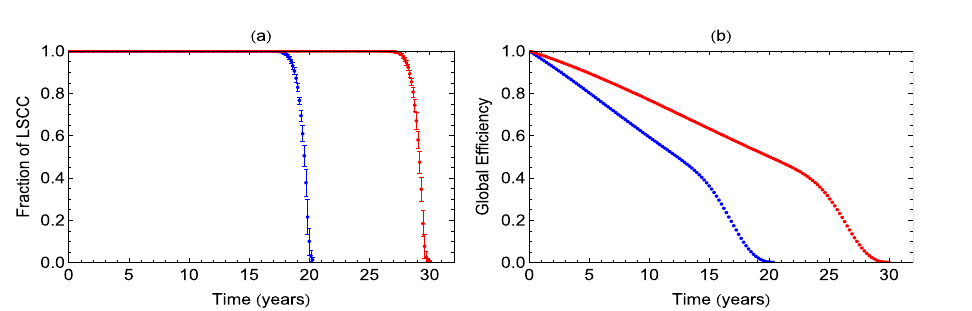
Figure 5. Decrease in fractional size of LSCC ( a ) and Global Efficiency ( b ) for various types of initial distributions of synaptic coupling strengths. (i) identical coupling strengths (ii) normal distribution and (iii) log-normal distribution.